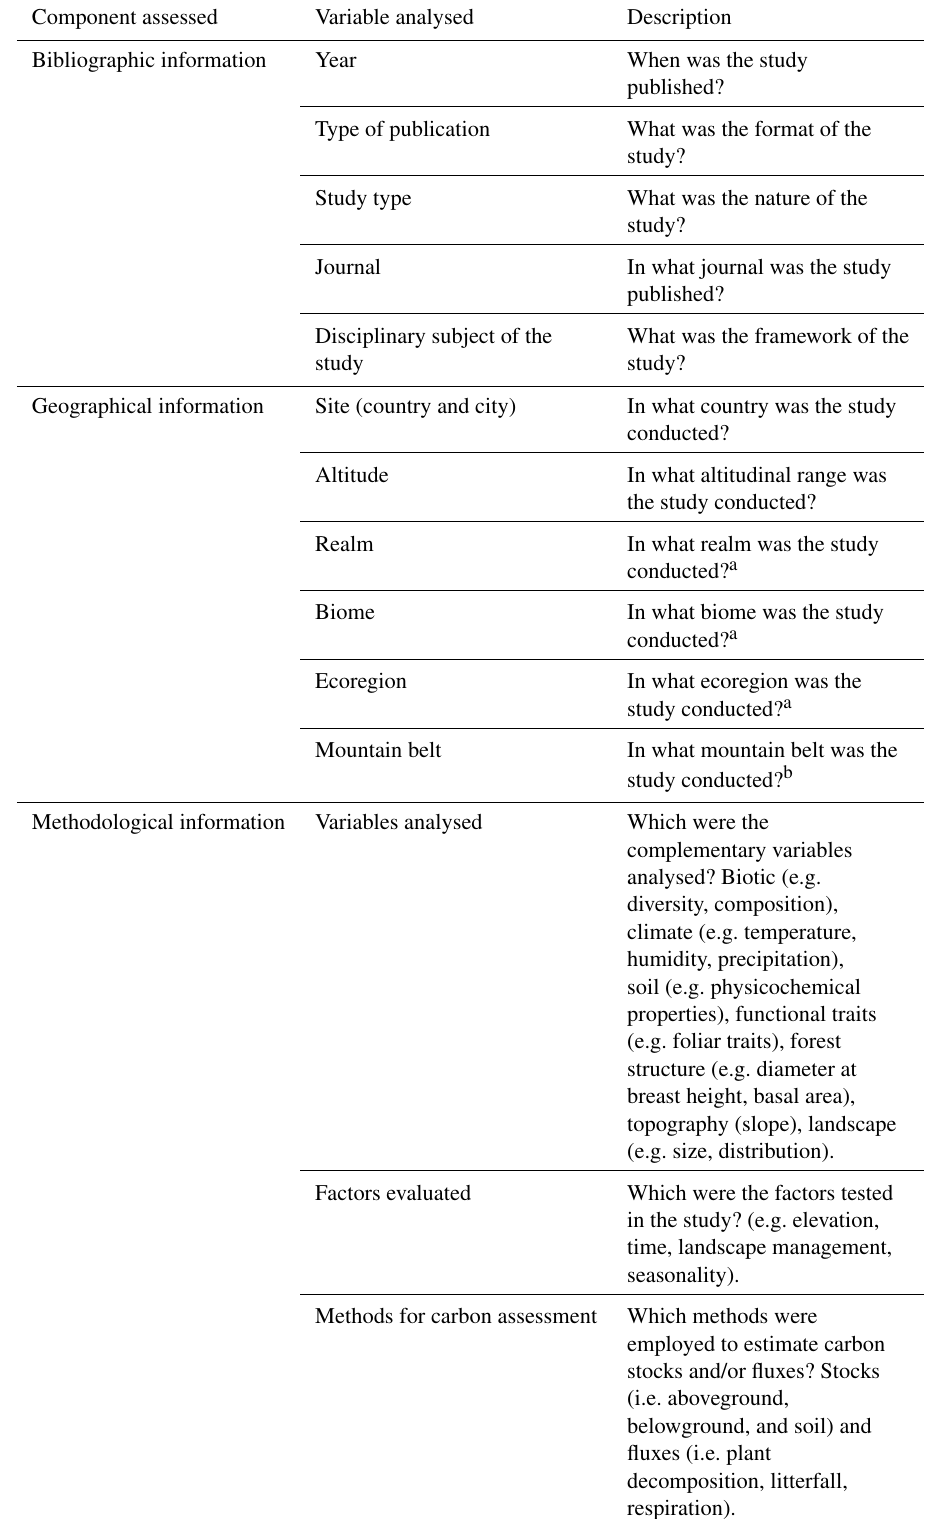
Table 1. General description of the components identified in the individual assessment of the article